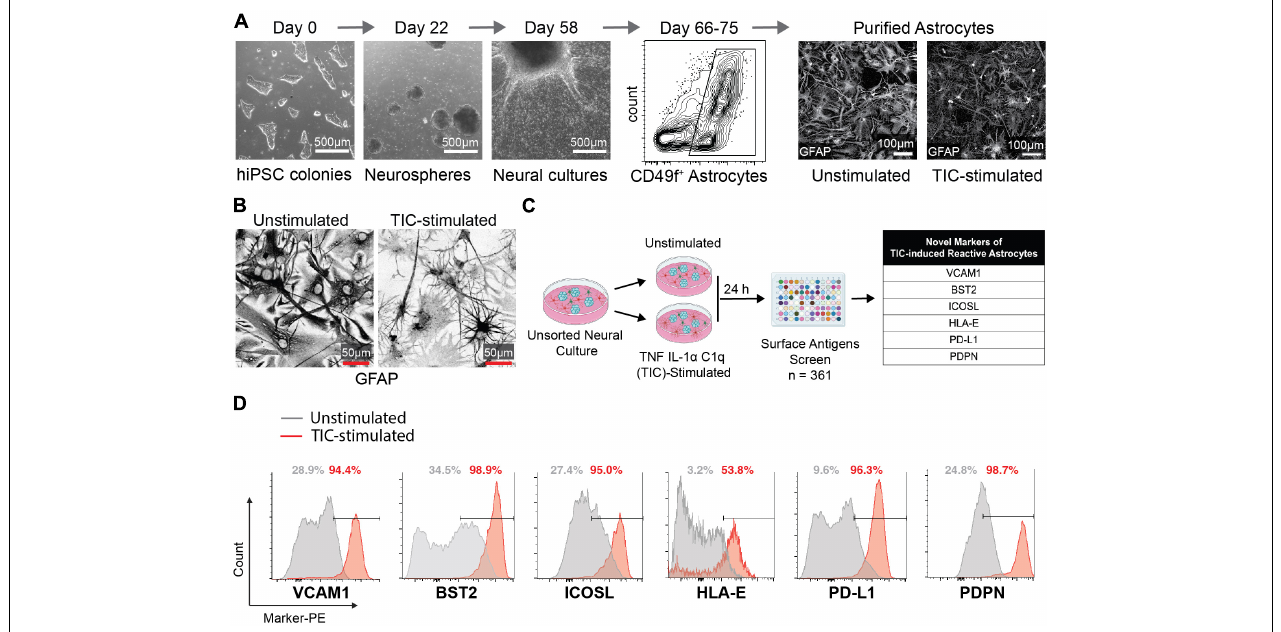
FIGURE 1 | Flow cytometry screen identifies novel markers for neurotoxic TIC-induced reactive astrocytes. (A) Representative images of major timepoints in hiPSC differentiation protocol into astrocytes. Between days 66 and 75 astrocytes are purified using CD49f (representative flow cytometry contour plot shown). Immunofluorescence staining for GFAP in unstimulated and TIC-induced reactive astrocytes highlights the change in morphology caused by proinflammatory stimulation. (B) Representative images of GFAP immunofluorescence staining in unstimulated and TIC-induced reactive astrocytes at high magnification. We used inverted grayscale to emphasize the changes in morphology caused by proinflammatory stimulation. (C) Schematic of flow cytometry screening of 361 PE-conjugated antibodies identifies six novel markers of TIC-induced reactive astrocytes, listed in the table. (D) Flow cytometry detection of each marker from the screen is shown as histogram plot comparing TIC-induced reactive (red) to unstimulated (gray)